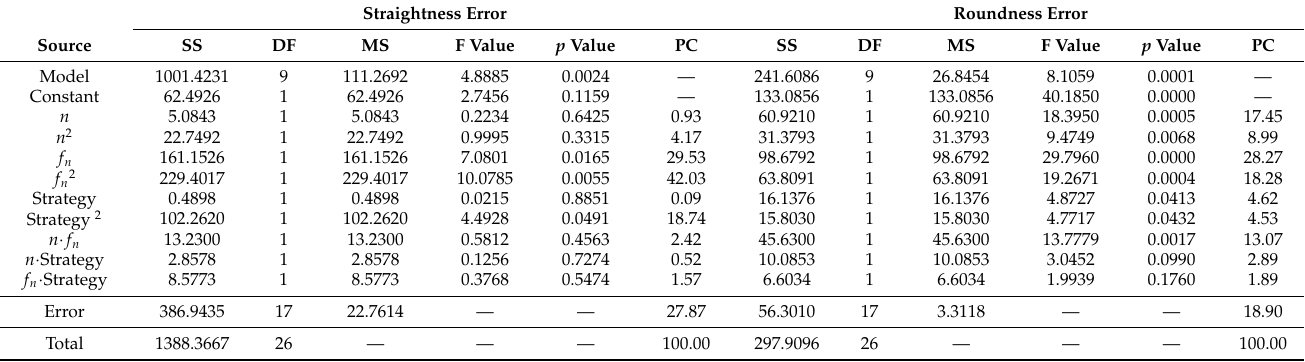
Table 3. Results of the statistical analysis, ANOVA, for the hole straightness and roundness errors.